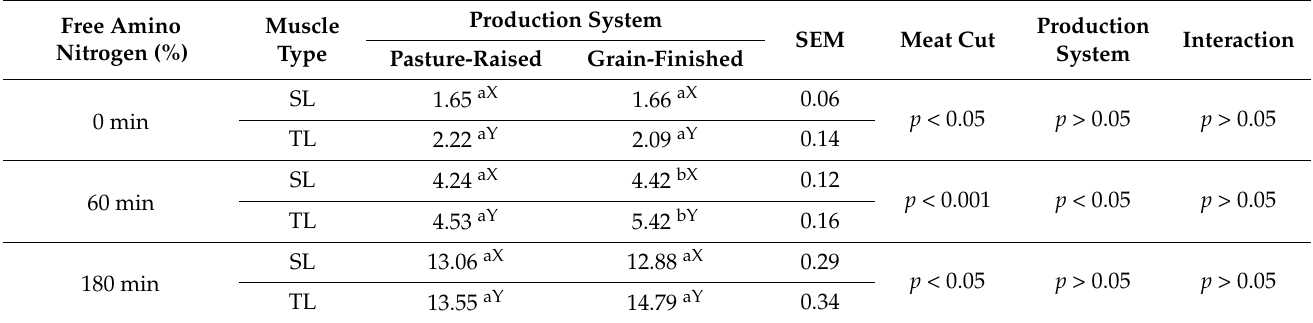
Table 2. Free amino N (%) release during simulated gastro-small intestinal digestion of pasture-fed and grain-finished cooked striploin and